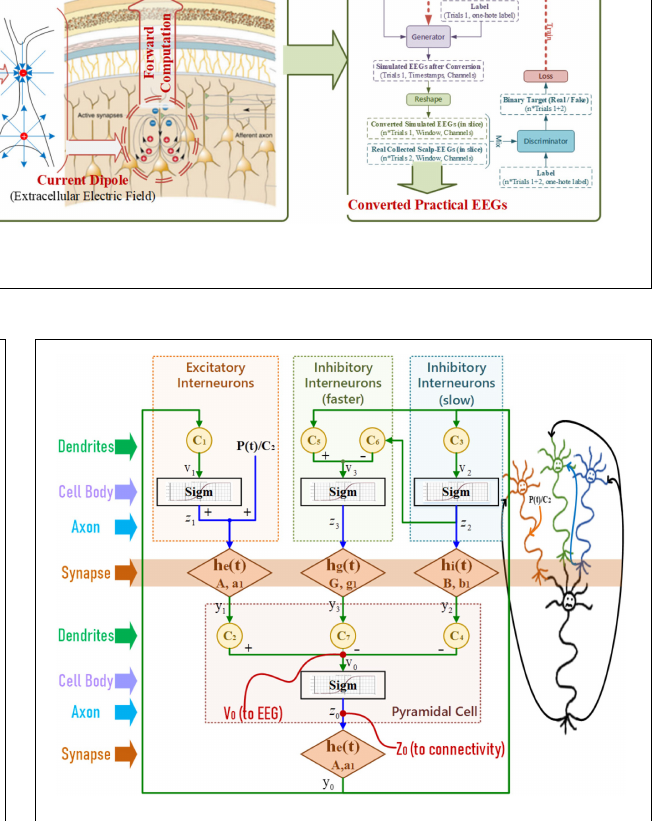
FIGURE 3 | The structure of a single population